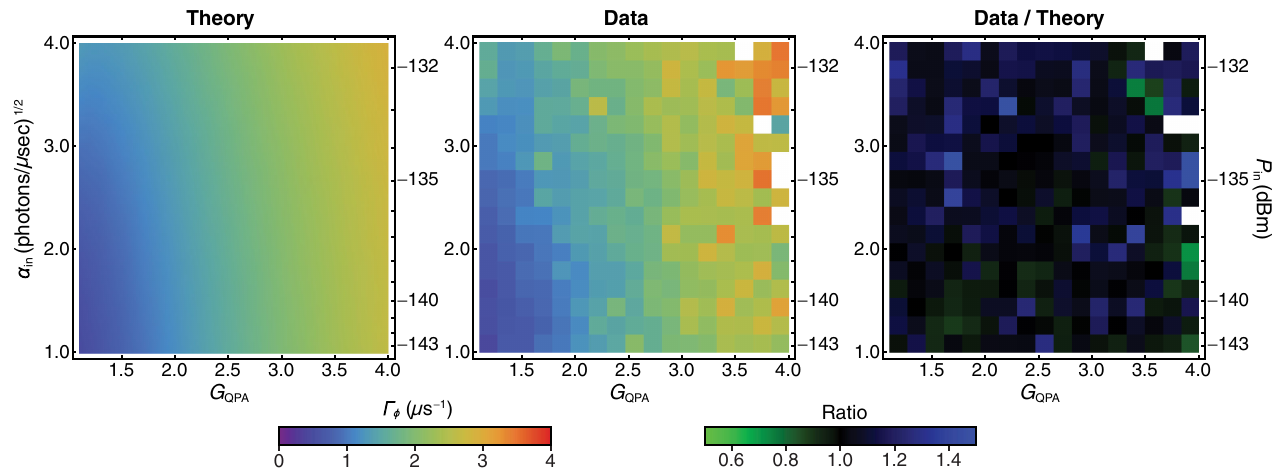
FIG. 6. Dephasing rate Γ ϕ as a function of measurement strength j α Eq. (4), while the central panel shows the Γ ϕ values inferred from observation. The ratio of the data to the theory prediction is displayed in the right panel.